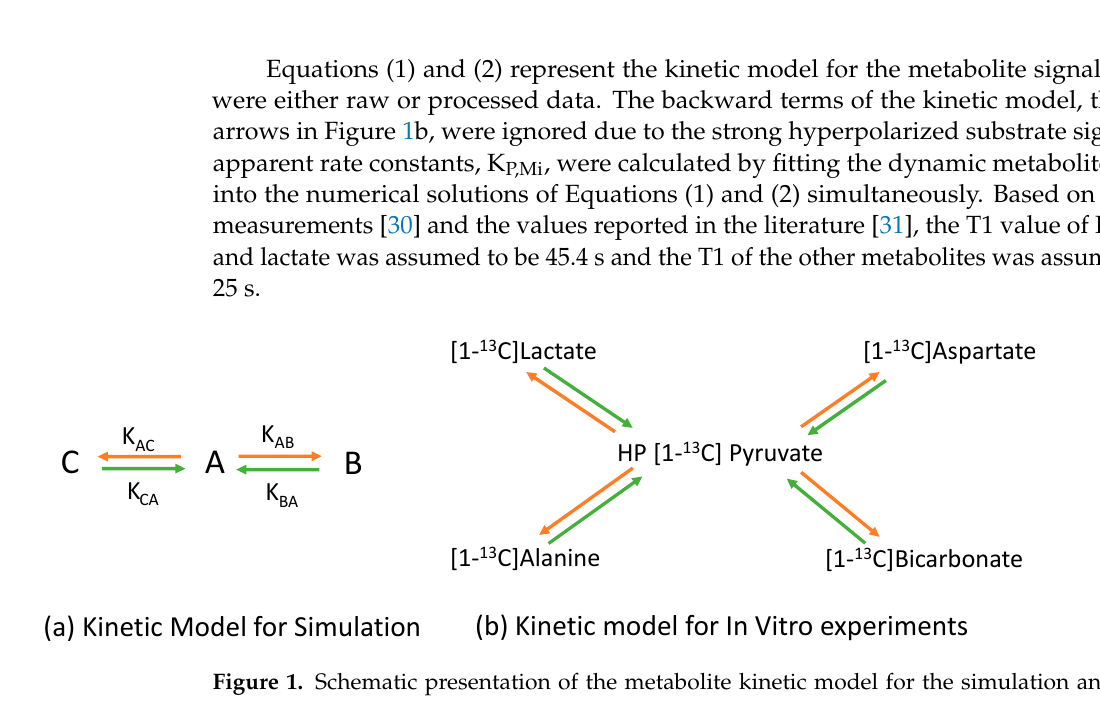
Figure 1. Schematic presentation of the metabolite kinetic model for the simulation and in vitro studies. The orange arrows represent a substrate converting to metabolites [1,32]. The green arrows represent metabolites converting to the substrate. ( a ) “A” is the substrate and “B” and “C” are metabolites transferred from the “A” substrate. ( b ) HP [1- 13 C]Pyruvate is the substrate. Other metabolites are transferred from the HP [1- 13 C]Pyruvate.